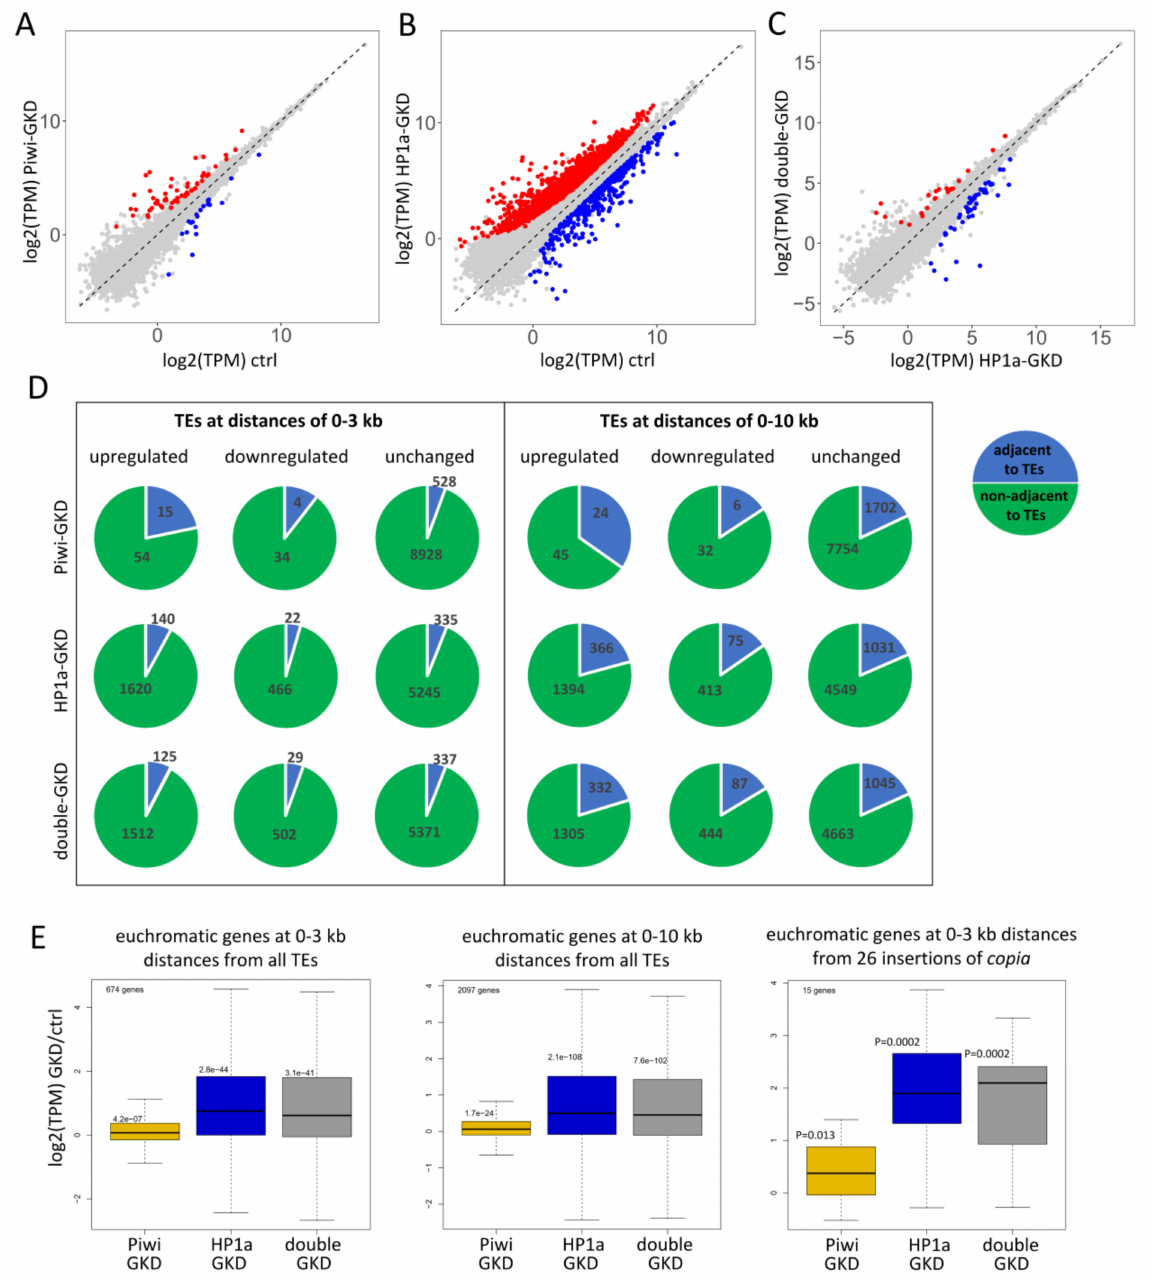
Figure 5. Contribution of Piwi and HP1a to the regulation of protein-coding genes in the germline. ( A , B ) Scatterplots showing transcript levels (log2 TPM) of genes upon Piwi-GKD ( A ) and HP1a-GKD ( B ) versus the control. Significantly up- and downregulated genes are indicated by red and blue dots, respectively. ( C ) Scatterplot showing the expression of genes in HP1a-GKD versus Piwi/HP1a double-GKD ovaries. ( D ) Number of euchromatic genes that were >2-fold upregulated, downregulated or did not change expression upon Piwi-, HP1a- and double-GKD. Blue sectors show the number of genes adjacent to TE insertions at distances up to 3 kb or 10 kb, and green sectors show the number of genes nonadjacent to TE insertions. ( E ) Boxplots indicating fold changes (log2) in the RNA-seq TPM values upon Piwi-, HP1a- and double-GKD for euchromatic genes adjacent to the insertions of all TEs at distances up to 3 kb or 10 kb and for euchromatic genes adjacent to insertions of the copia element at a distance of up to 3 kb. In the boxplots, the median is represented by a thick horizontal line, the upper and lower hinges are the 75th and 25th percentiles, respectively, and the whiskers indicate the highest and lowest values. p -values were calculated according to the Mann–Whitney U